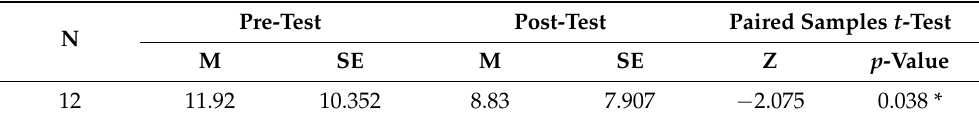
Table 4. Wilcoxon signed ranked test with Baker Depression Inventory-II (BDI-II) Second Edition. N